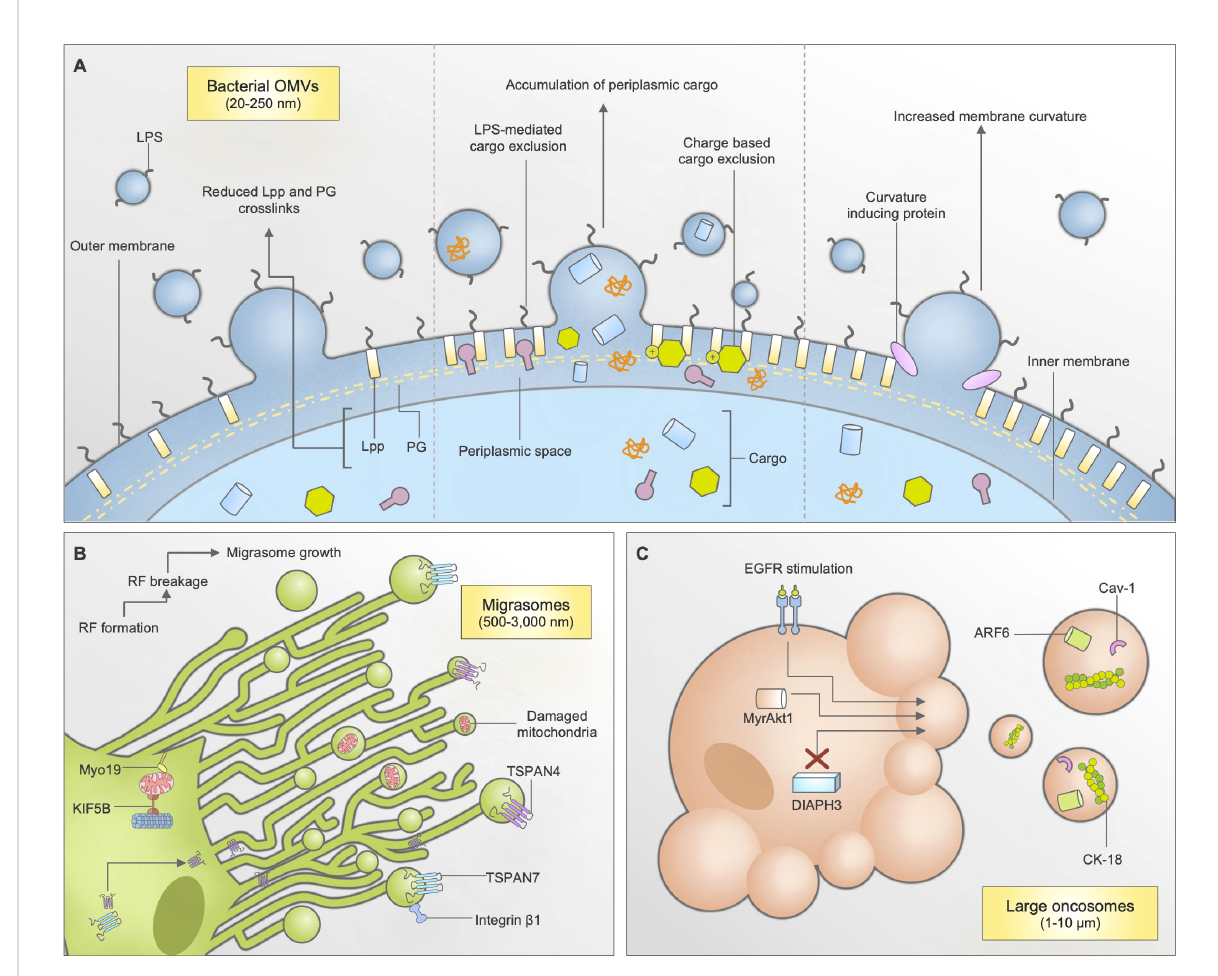
FIGURE 2 Biogenesis and cargo packaging mechanisms of bacterial outer membrane vesicles (OMVs), migrasomes, and large oncosomes (LOs). (A) Bacterial OMVs can be released through multiple mechanisms: through reduction in lipoprotein (lpp) and peptidoglycan (PG) crosslinks, accumulation of cargo within the periplasmic space, and increases in membrane curvature due to curvature inducing proteins. Cargo packaging mechanisms are largely unknown, however some bacterial species have indicated charge-based and lipopolysaccharide (LPS) mediated mechanisms. (B) Migrasomes are formed through a migration-dependent mechanisms, predominantly found in epithelial cells. As cells migrate, retraction fi bres (RFs) form on the extracellular matrix. As the cell continues to move, the RF breaks and begins to form small, bulbous structures known as migrasomes. Tetraspanins TSPAN4 and TSPAN7 are known to be important for this process, and are recruited through the retraction fi bres. When mitochondrial stress occurs, cells can also shuttle damaged mitochondria for disposal using mitocytosis, dependent on KIF5B and Myo19. (C) Large oncosomes are generated by prostate cancer cells during a non-apoptotic form of membrane blebbing. This occurs following EGFR stimulation, DIAPH3 silencing, or by activation of